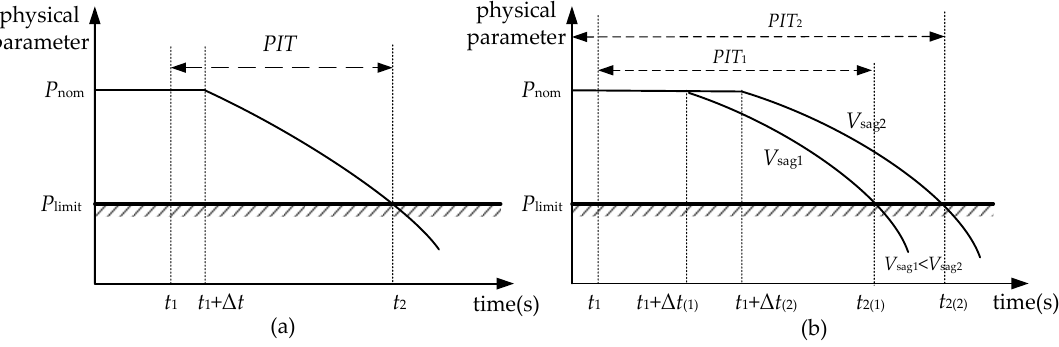
Figure 3. The definition of process immunity time (PIT), ( a ) is PIT of a single voltage sag magnitude, ( b ) is PIT of different voltage sag magnitudes.